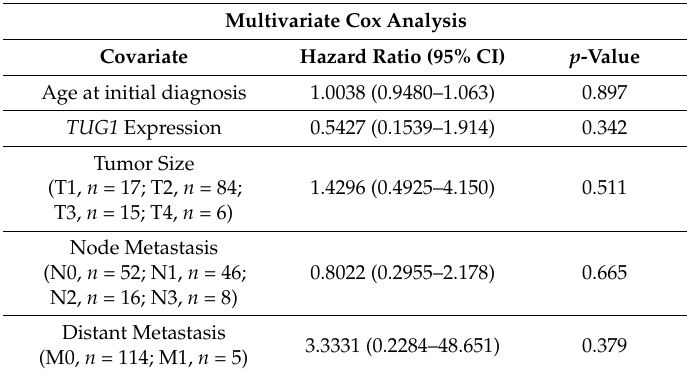
Table 1. Multivariate Cox analysis of luminal B samples.